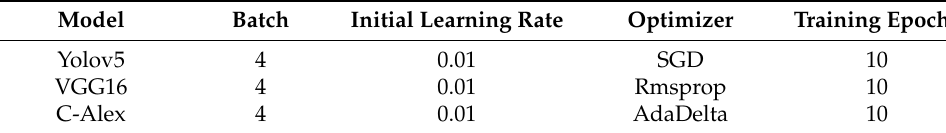
Table 3. Model Hyper parameter se tt ings in the second part of the study.